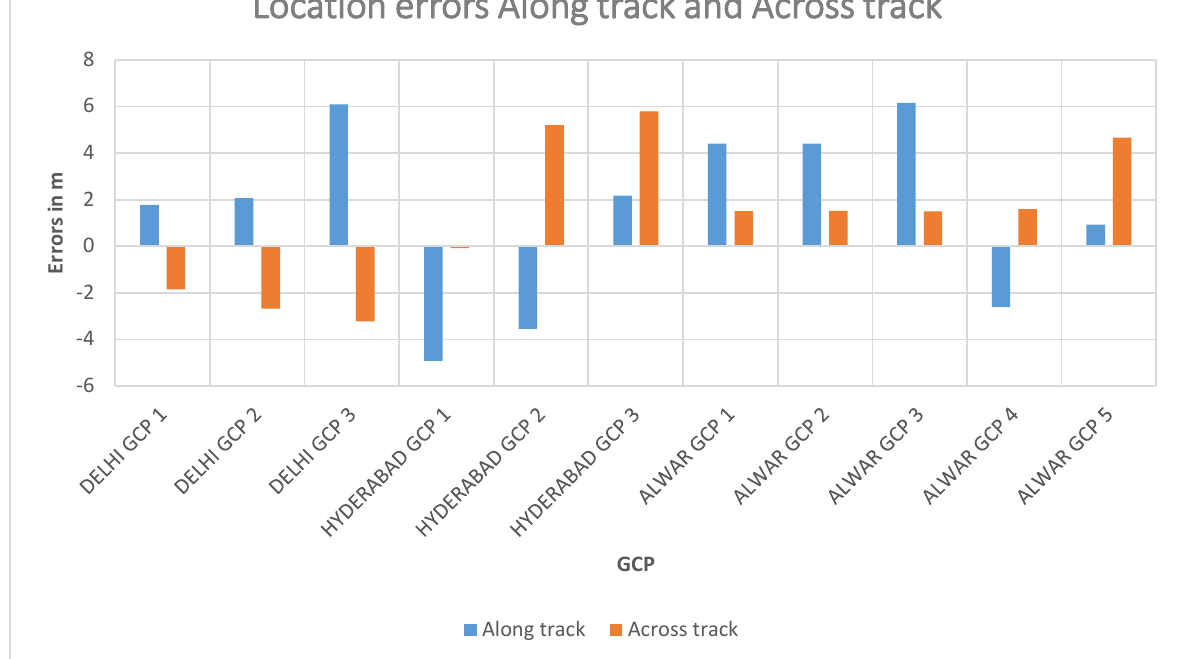
Along track Across Figure 4. Graphical representation of Location Errors